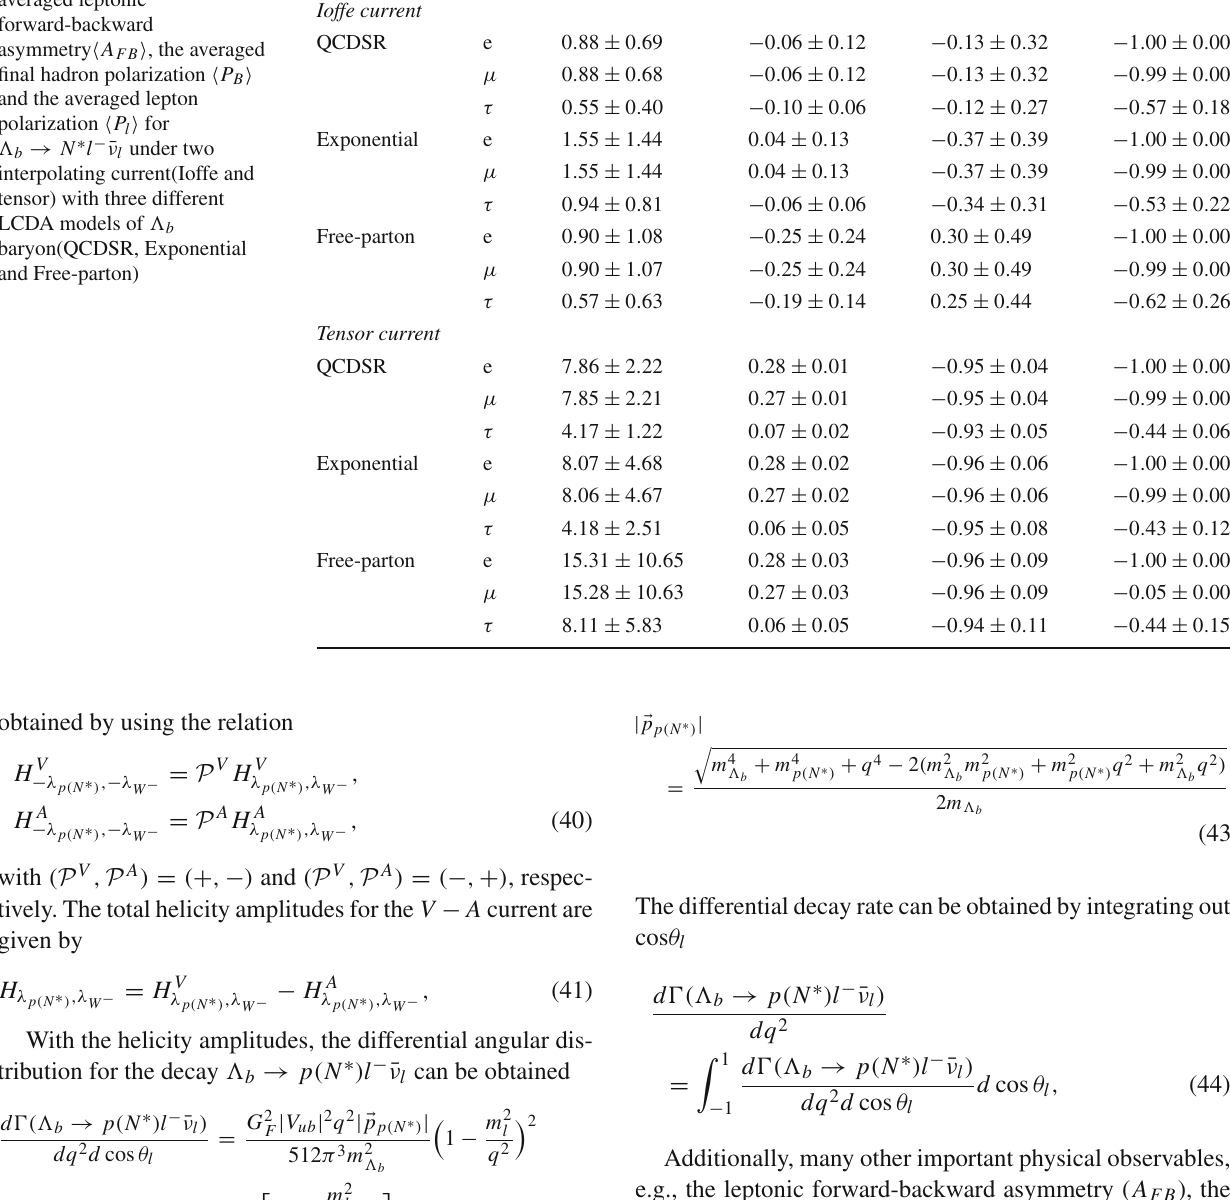
Table 6 The predictions for the branching fractions, the averaged leptonic